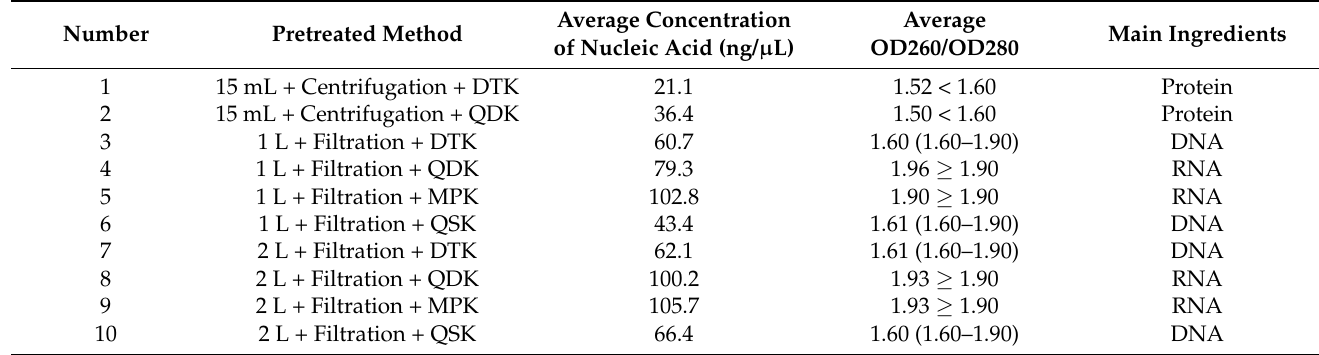
Table 2. The concentration of nucleic acid and the value of OD.